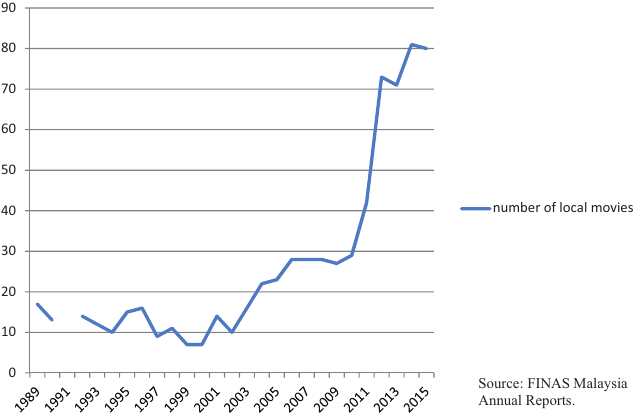
Figure 1. Annual number of local movies (1989–2016) (source: FINAS Malaysia Annual Reports (1989–2007) (see Finas, 2018; FINAS,